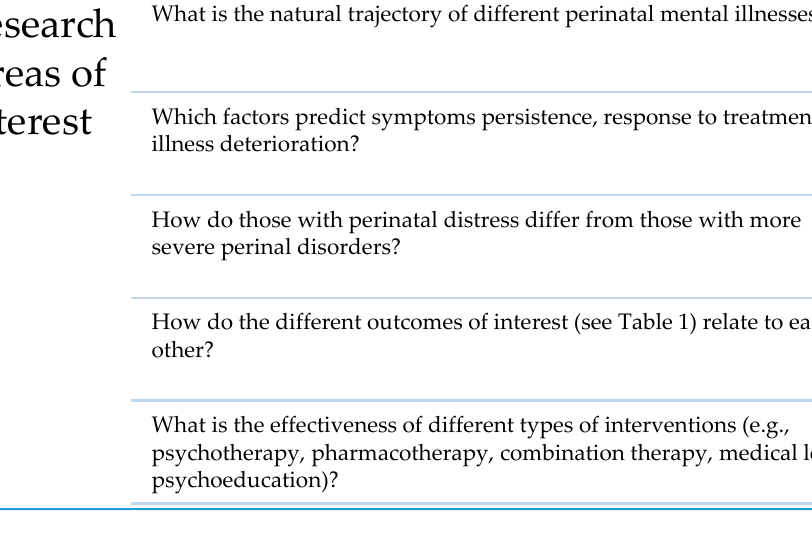
Figure 1. Research areas of interest.